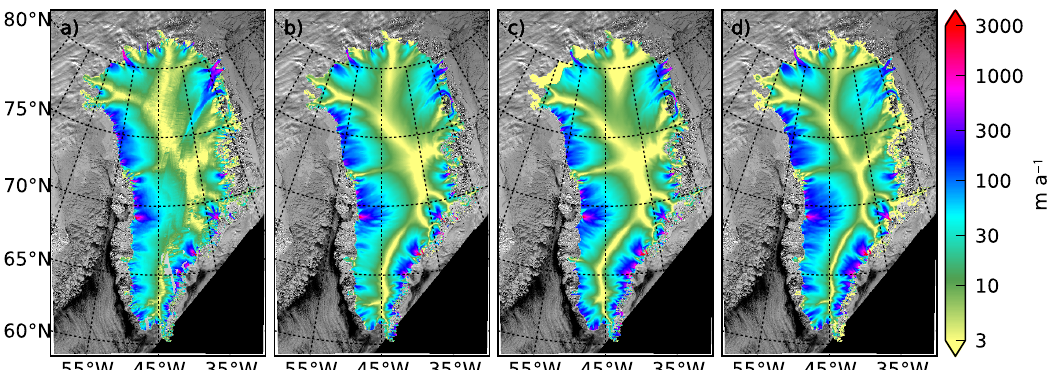
Fig. 1. Measured and modeled horizontal surface speeds. (a) SAR (Joughin et al., 2010). (b) “constant-climate” hindcast. (c) “paleo-climate” hindcast. (d) “flux-corrected” paleo-climate hindcast. Values are in meters per year. Surface speeds are masked where observed ice thickness is less than 100m. Table 1. Initial states and model performance statistics. The RMSE is given for the comparison of simulated surface speeds of the initial state (1989) and the observed 2006–2009 average (Joughin et al., 2010); see Supplement Table 4.1 for details. Also listed are observed ice volume and GRACE trend (Luthcke et al., 2013), the correlation coefficient, r , and the detrended correlation coefficient, ˜ r . Ice volume is calculated by integrating ice thickness in space and multiplying by the density of ice (910kgm − 3 ). observed “constant-climate” “paleo-climate” “flux-corrected” ice volume initial volume [10 6 km 3 ]